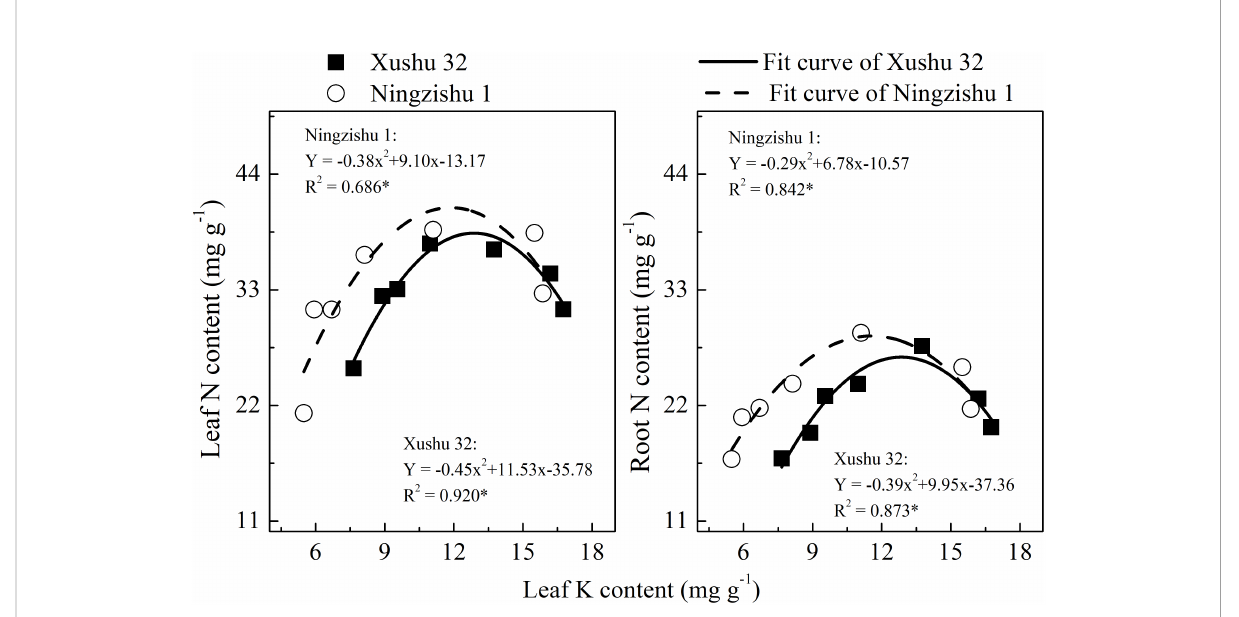
FIGURE 2 Relationship between leaf nitrogen (N) content, root N content, and leaf potassium (K) content. The solid and dotted lines represent Xushu 32 and Ningzishu 1, respectively; * mean signi fi cant at the p < 0.05 probability